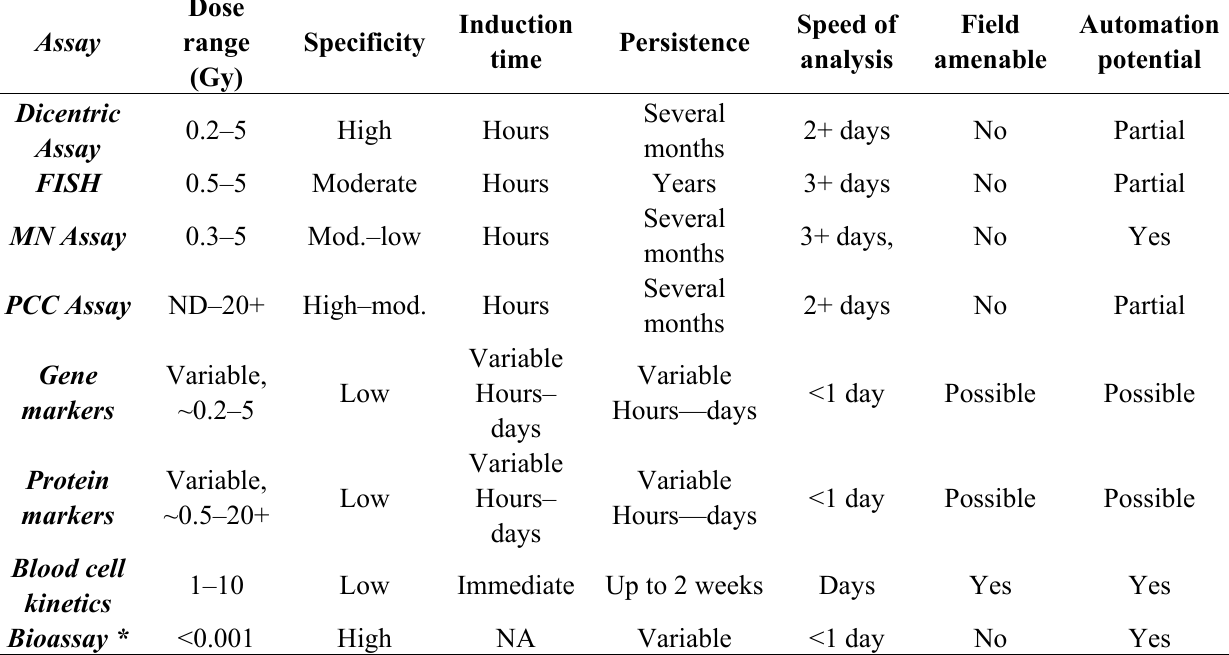
Table 2. Examples of radiation biomarker assays and exposure assessment methods.